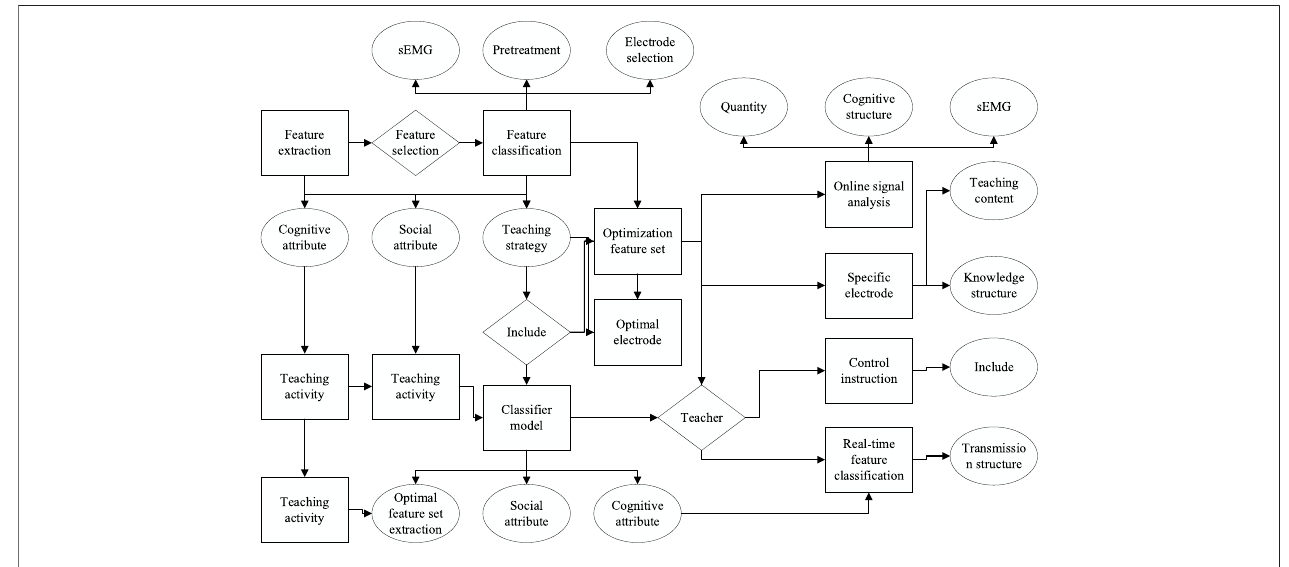
FIGURE 4 | Flow chart of signal feature